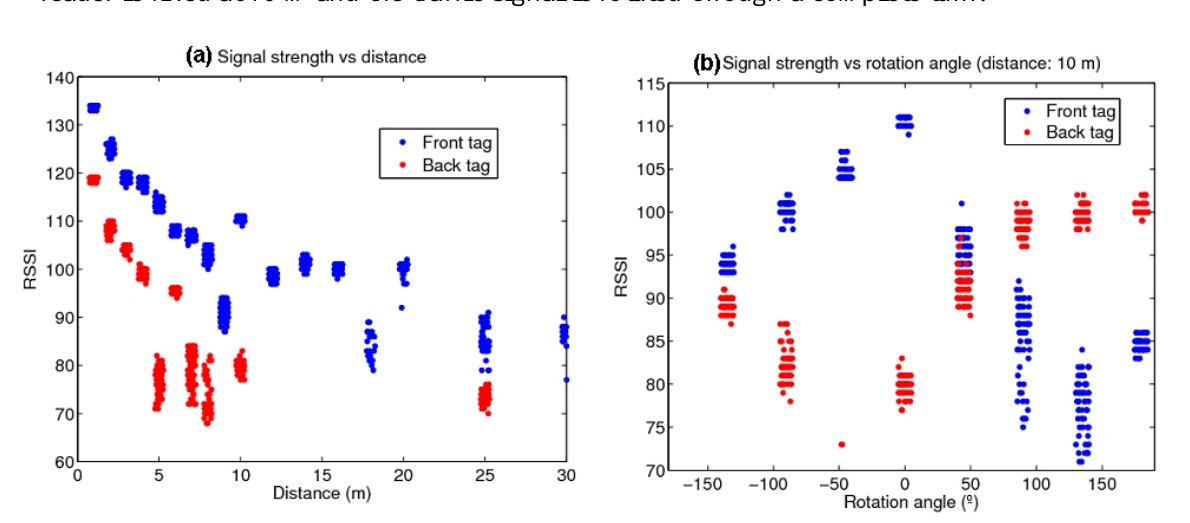
Figure 2. Signal strengths of tags placed in the front and back sides of the traffic signal, as (a) the reader is placed in front of the signal and its longitudinal distance is varied; (b) the reader is fixed at 10 m and the traffic signal is rotated through a complete turn.